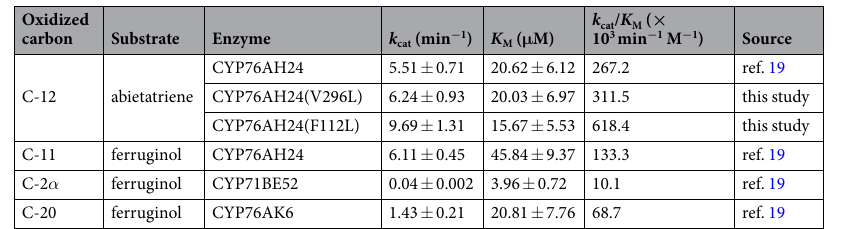
Table 3. Kinetic parameters of the engineered CYP76AH24